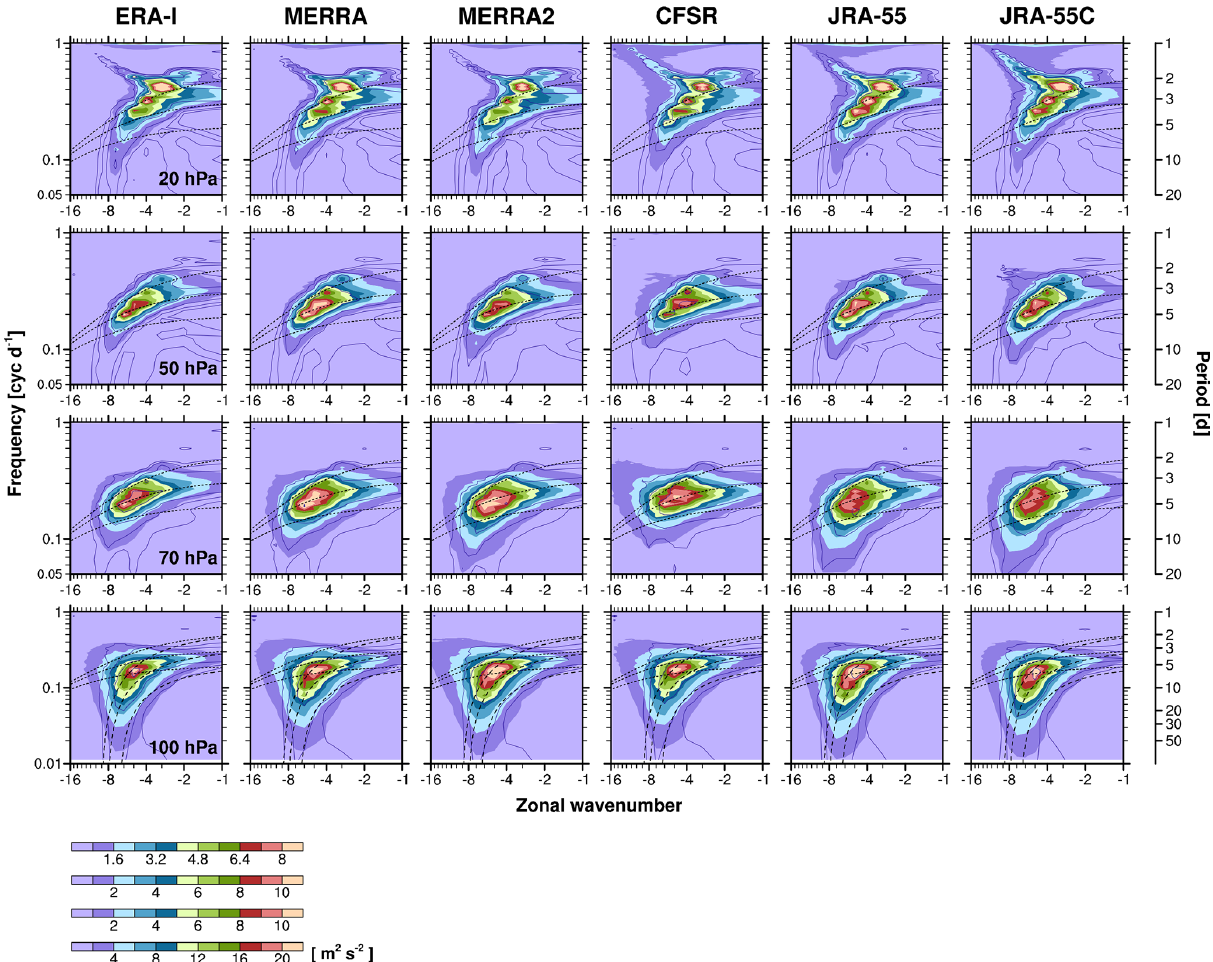
Figure 2. The same as in Fig. 1 except for the spectra of the symmetric component of meridional wind. The mixed Rossby–gravity (MRG) wave dispersion curves for the windless background state are indicated by the dotted lines for h = 8, 60, and 480m. At 100hPa, the dispersion curves for the background zonal wind of + 10ms − 1 are also indicated by the long-dashed